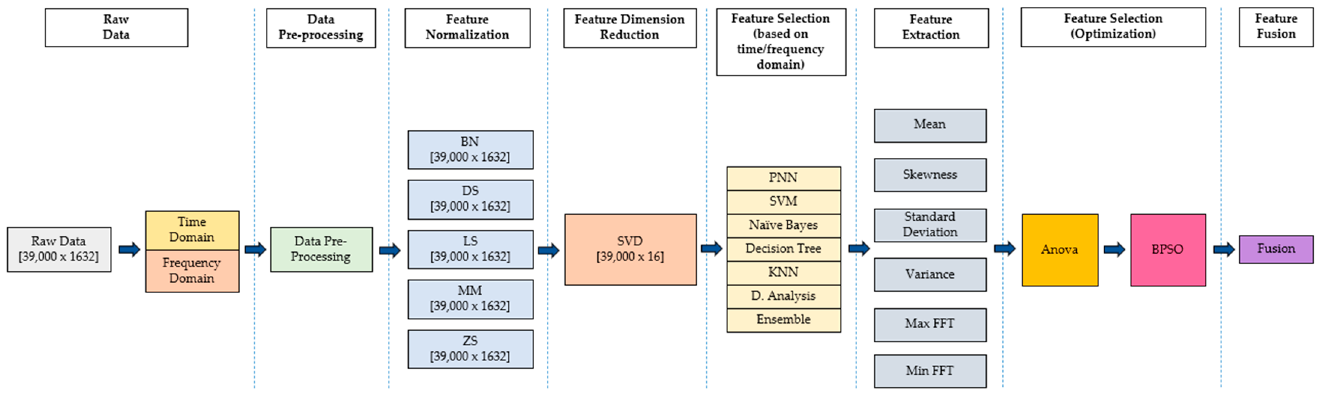
Figure 7. MSFS–BPSO framework.